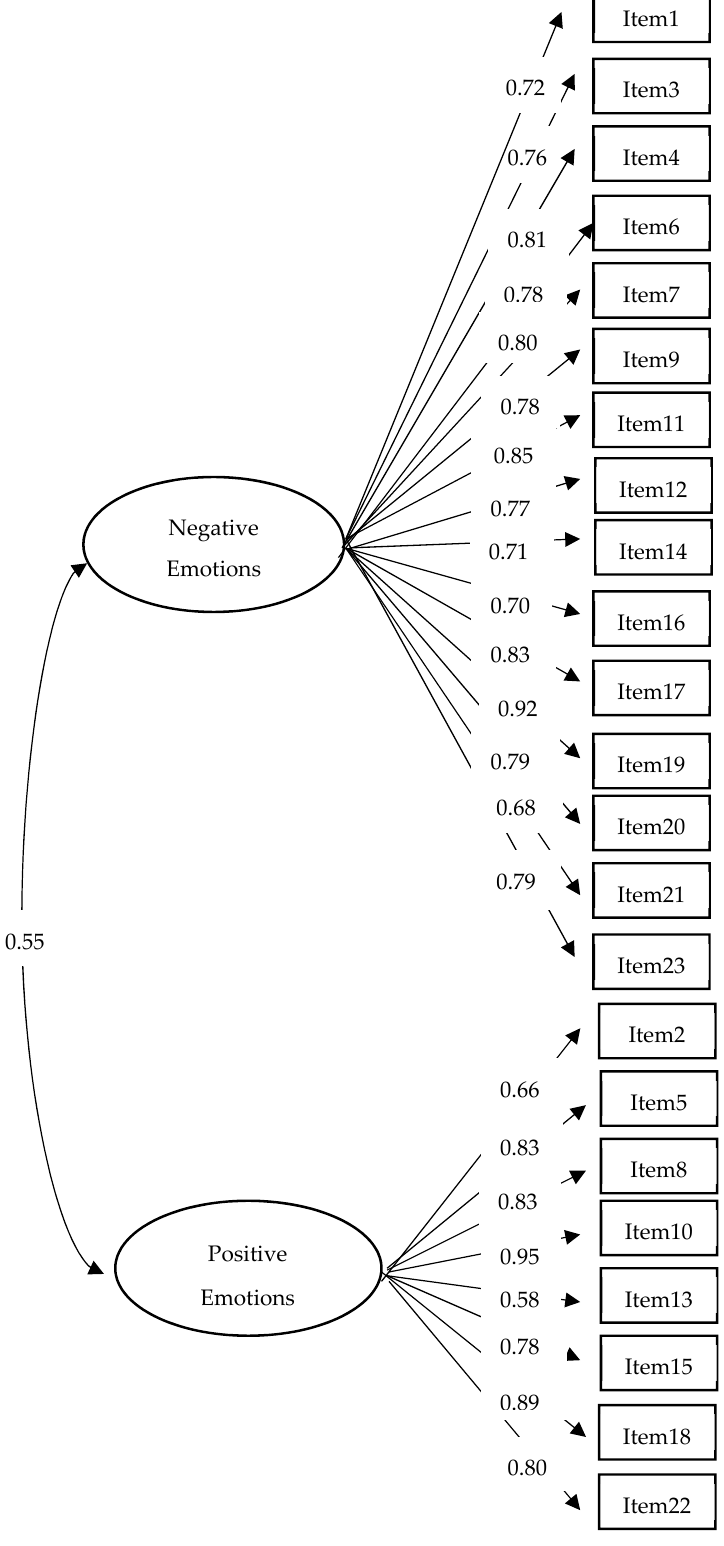
Figure 2. Standardized factor loadings for the two-factor model. scores, F (1, 231) = 13.219, p = 0.000. People working in the adult service had